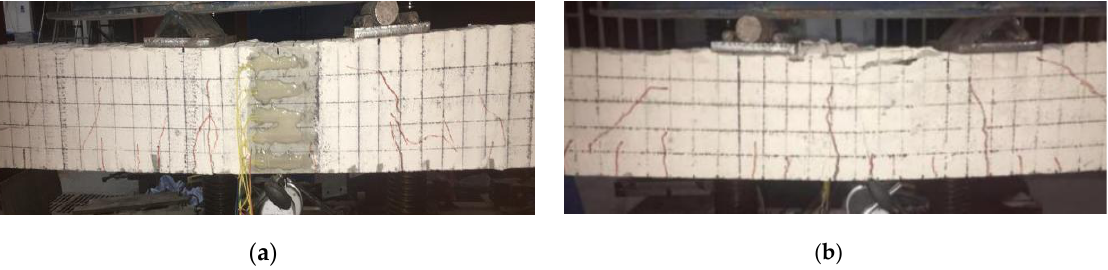
Figure 7. Ceramsite concrete beam damage pattern. ( a ) L1 beam damage pattern. ( b ) L2 beam damage pattern.